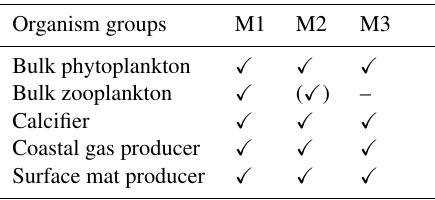
Table 1. Organism groups that drive climate mechanisms: M1: bio- geochemical pumps; M2: gas and particle shuttle and M3: biogeo- physical mechanisms. Note that zooplankton is partly involved in the production of DMS due to grazing and thus checked in paren- thesis. Organism groups M1 M2